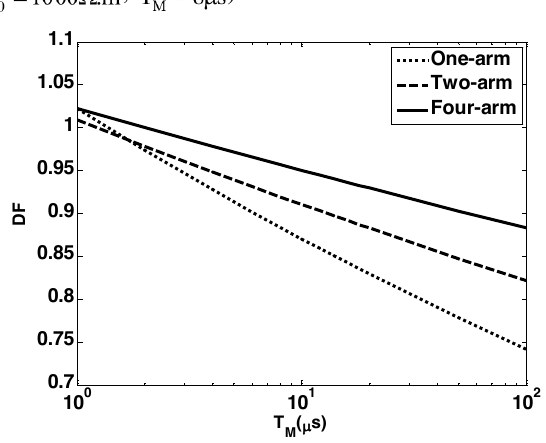
Figure 16: Variation of DF versus for counterpoise wires.